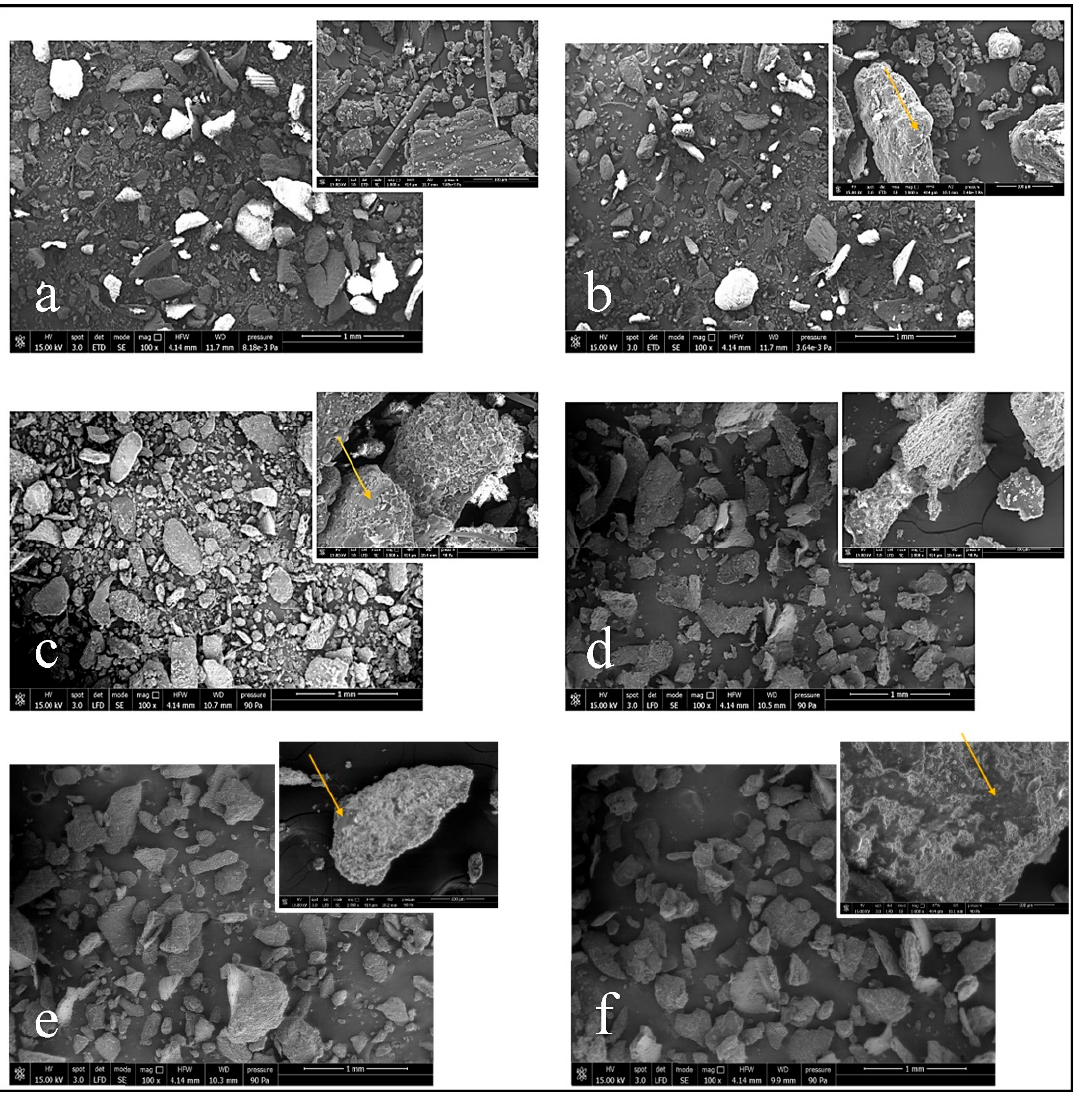
Figure 2. SEM of ( a ) Wheat ( b ) WB + 4 wt.% beeswax ( c ) WB + 8 wt.% beeswax ( d ) Rice ( e ) RB + 4 wt.% beeswax ( f ) RB + 8wt.% beeswax. Yellow arrows to highlights the wax wetting.